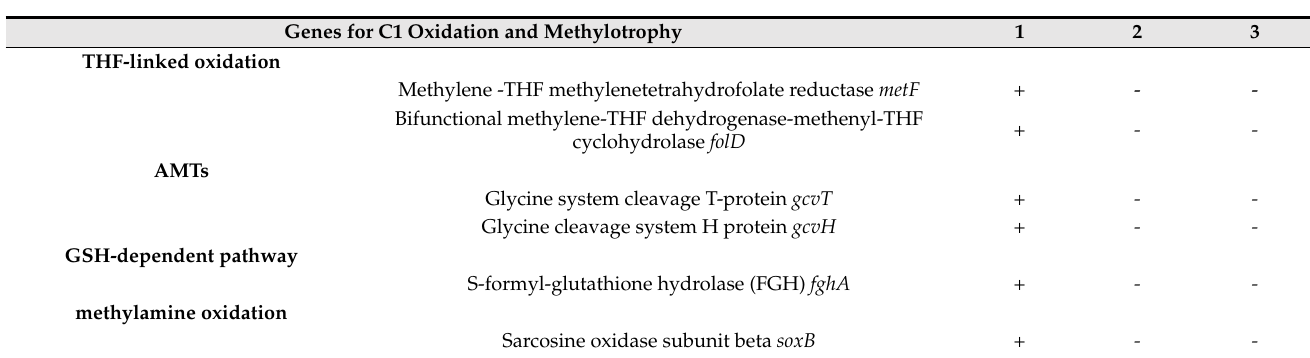
Table 7. Distribution of genes involved in C1 metabolism in 1, Pacificimonas pallium WHA3 T ; 2, Pacificimonas flava DSM 107612 T ; 3, Pacificimonas aurantium DSM 107782 T genomes using https: //narrative.kbase.us/ accessed on 24 February 2022.